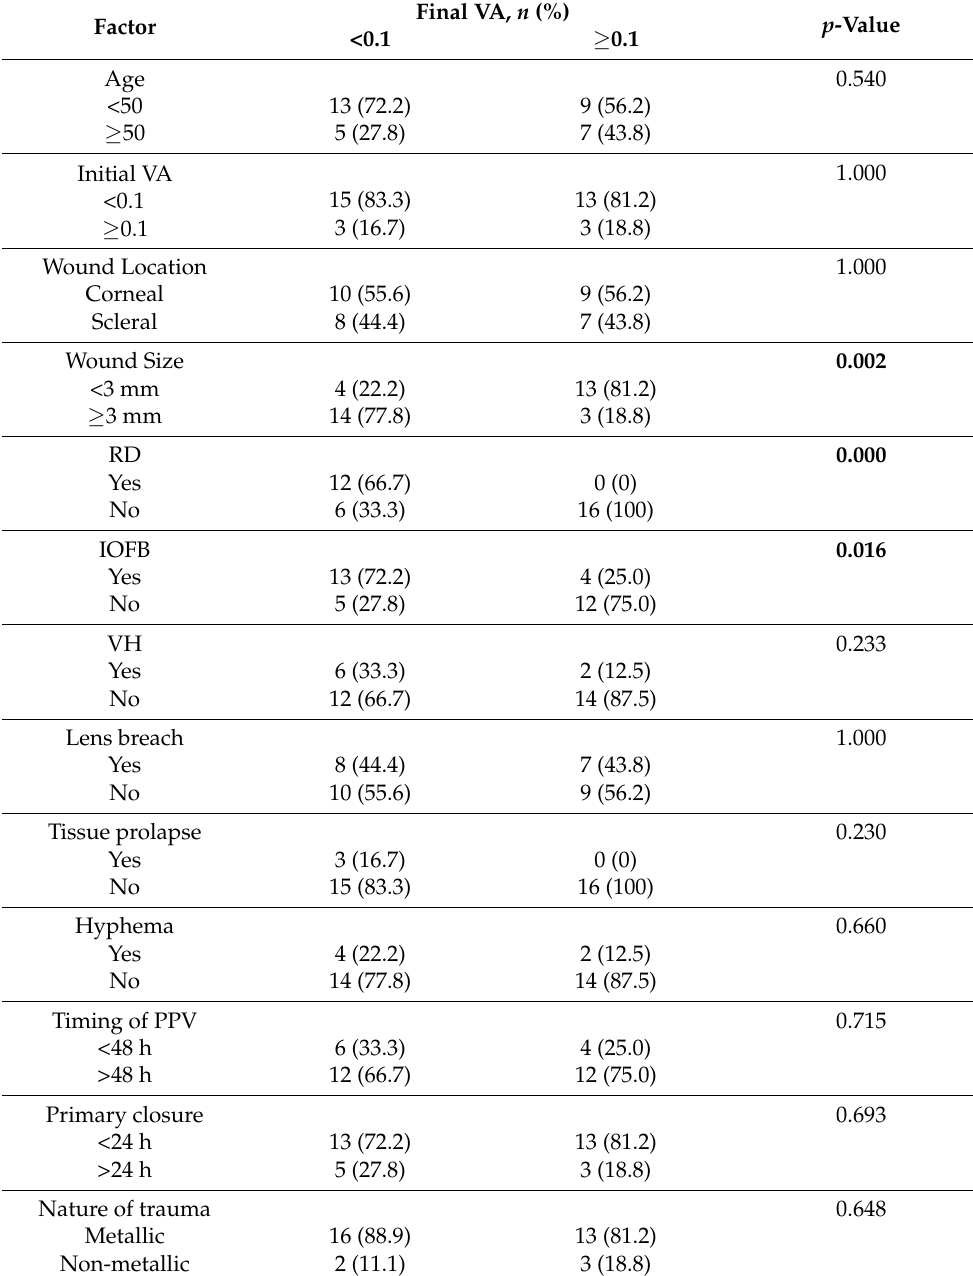
Table 5. Prognostic